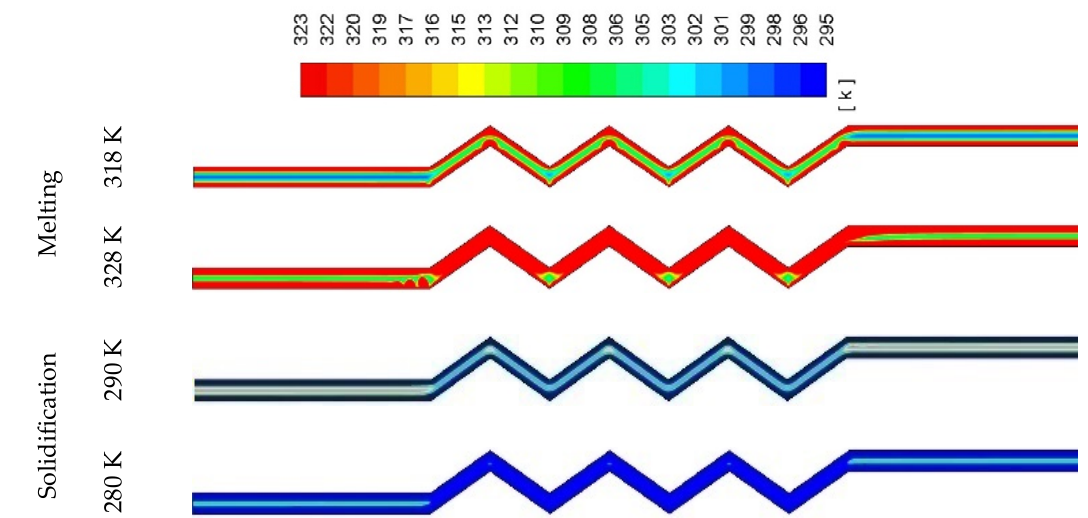
Figure 25. Contours of the temperature in the melting and solidification processes for different airflow temperatures after 200 s.